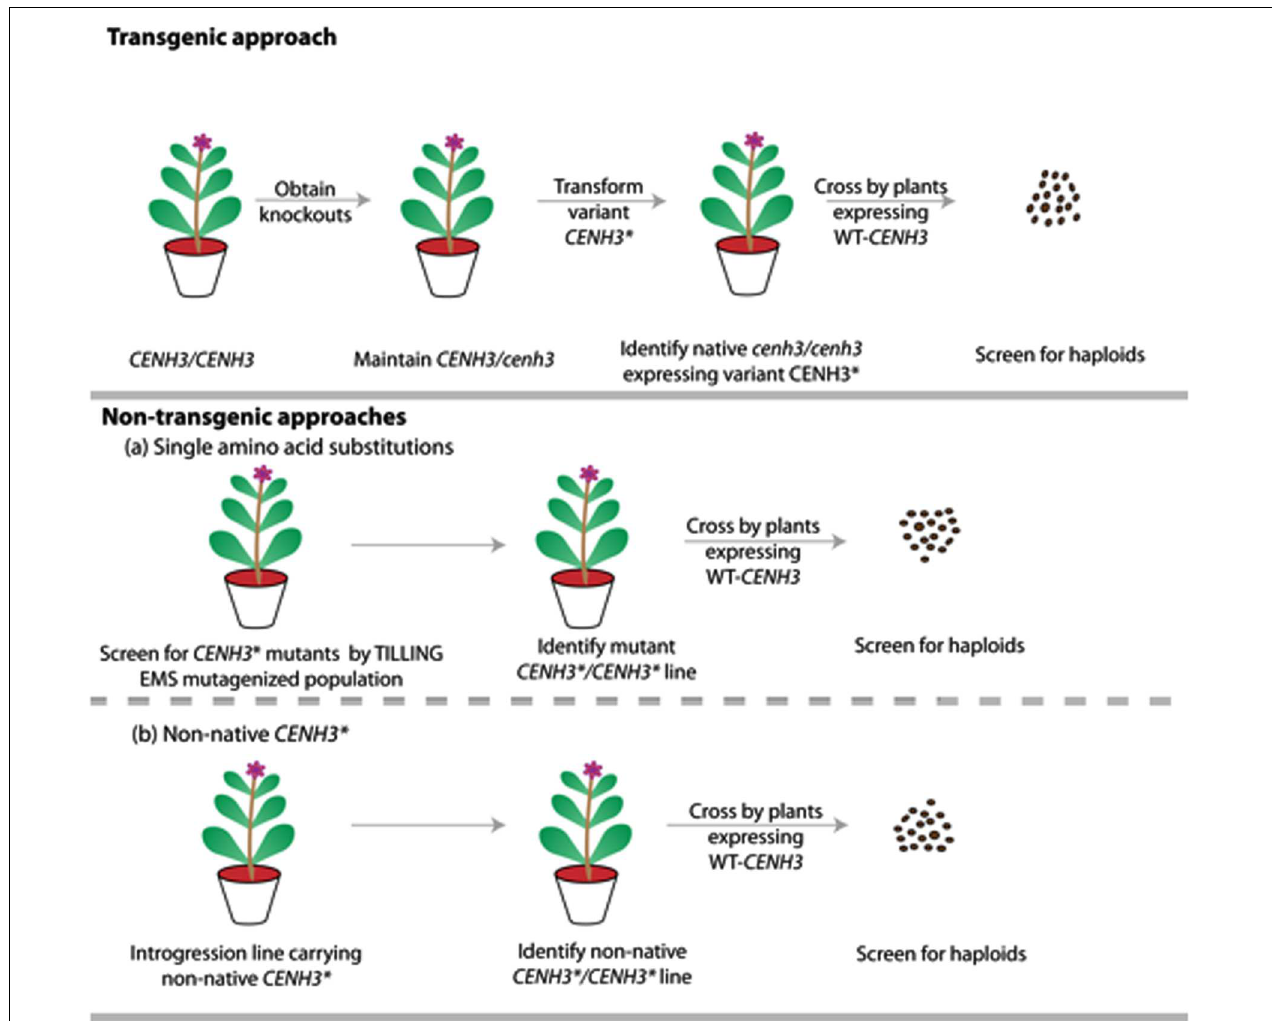
FIGURE 3 | Schematic representation comparing the steps involved in generating haploids by transgenic vs. non-transgenic approaches. The transgenic approach involves generating CENH3 knockouts by TILLING or genome editing, with transgenic addition of point mutant, non-native or GFP-tailswap alleles ( CENH3 ∗ ). The non-transgenic approach involves novel alleles, created either by chemical mutagenesis or though introgression of non-native CENH3 . This later non-native approach is hypothetical and is yet to be demonstrated in plants. CENH3 ∗ represents variant CENH3 (Point mutant CENH3/ Non-native CENH3/ GFP-tailswapCENH3